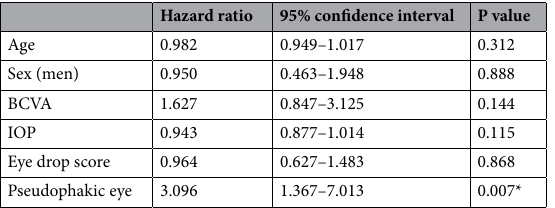
Table 2. Factors associated with achieving IOP < 15 mmHg and ≥ 20% reduction with no additional treatments compared with baseline. Cox proportional hazards model. BCVA best-corrected visual acuity, IOP intraocular pressure. **P <